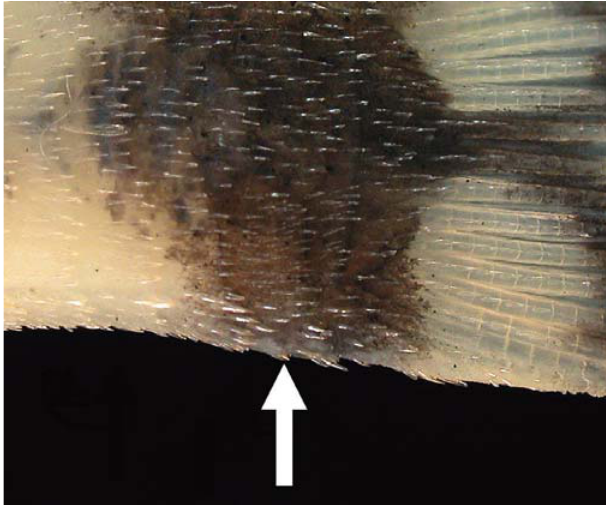
Fig. 2. Caudal fin of Otocinclus cocama , holotype, MUSM 20686, 43.5 mm SL, female, quebrada Yanayacu, Jenaro Herrera, Loreto, Peru. vet black, transverse bands, usually duplicated or forming roundish blotches in large specimens (Fig. 4). Additional layer of dark gray pigment in subjacent skin form with lateral blotches inconspicuous lateral stripe. Some pigmentation sometimes scattered or forming few dots on lateral portion of belly, between pelvic and anal fins, and on ventral face of caudal peduncle. Fins mostly hyaline. Outer face of pectoral spine pigmented with black; small patch of black chromatophores on unbranched pelvic- and anal-fin rays, sometimes on first branched anal-fin ray. Dorsal fin black at origin and with wide transverse, roughly triangular black band from spine to last branched ray, but leaving base and tip of rays white. Black spot on dorsal-fin spine and first branched ray sometimes divided in two patches. Caudal fin with W-shaped vertical band in distal half, but leaving narrow hyaline band at margin. Base of two central caudal-fin rays usually black, as prolongation of last caudal peduncle black blotch (Fig. 2). Color in alcohol . Color pattern as in living specimens, but white background turns into pale yellowish and black markings become faded or brownish (Fig. 1).